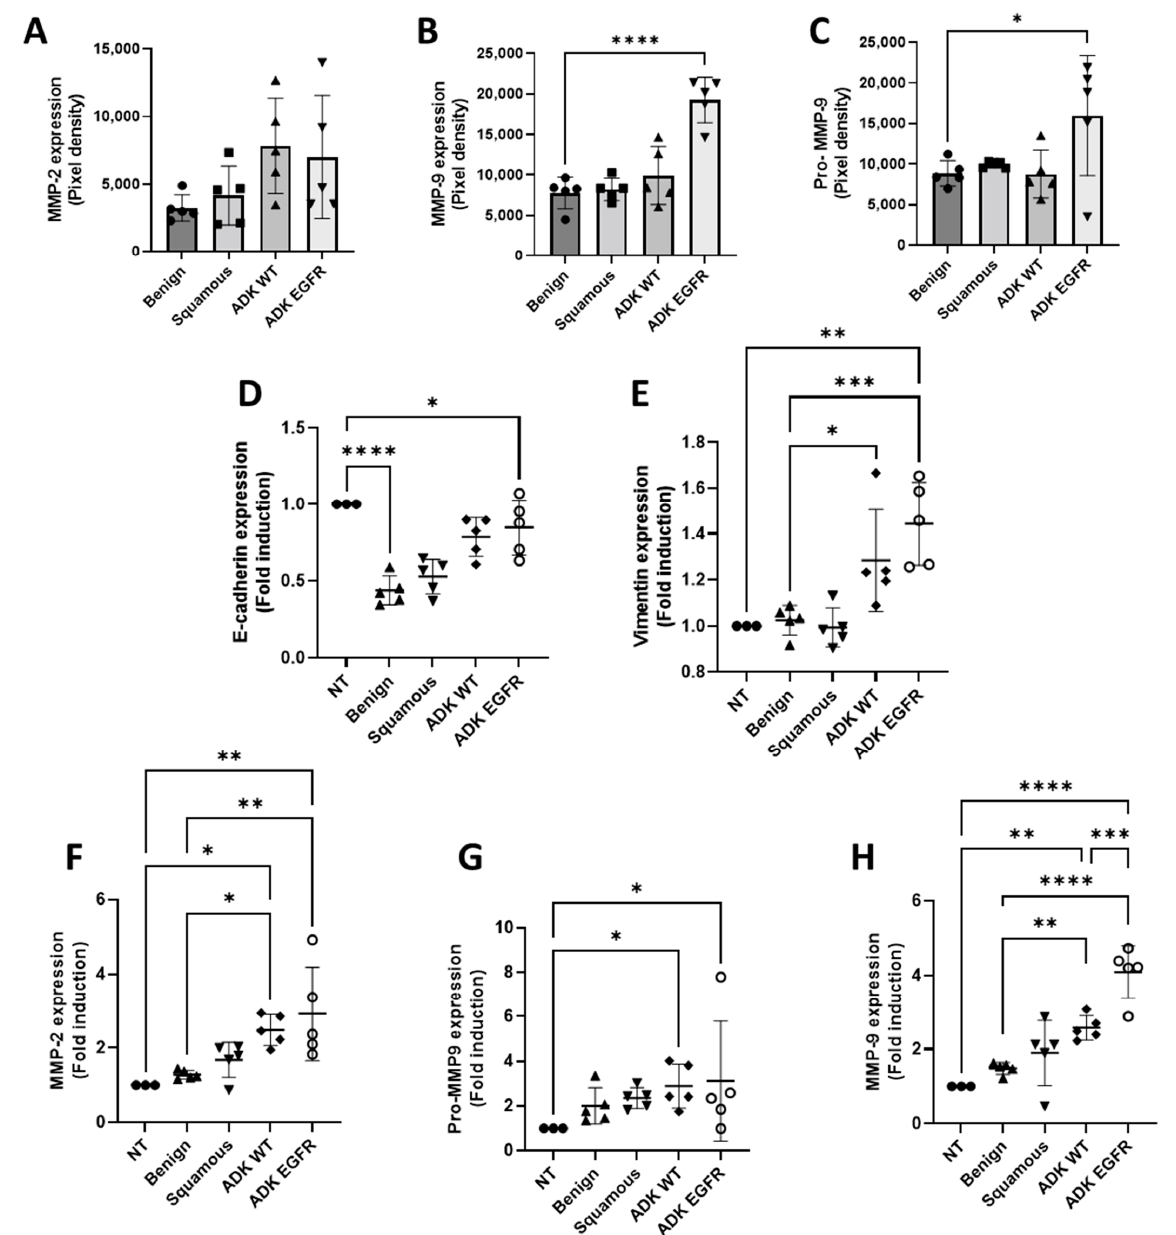
Figure 3. Exosomes from serum of EGFR -mutated patients promote extracellular matrix degradation and EMT-like process ( A – C ) Quantification analysis of expression of MMPs obtained by zymography in exosomes isolated from serum (mean ± SEM, n = 5). ( D , E ) Quantification analysis of vimentin and E-cadherin expression obtain by Western blotting of protein extracts of A549 cells treated with exosomes isolated from serum. GAPDH is used as a loading control (mean ± SEM, n = 5). ( F – H ) Quantification analysis of expression of MMPs obtained by zymography of supernatant of A549 cells treated with exosomes isolated from serum (mean ± SEM, n = 5). Significance was set at * p < 0.05, ** p < 0.01, *** p < 0.001 and **** p < 0.0001. To further investigate the functionality of exosomes isolated from serum from patients with EGFR mutation, we developed a cellular model mimicking their effects in vitro using exosomes from an EGFR -mutated cell line: HCC827 harboring EGFR Del E746-A750 in exon 19, the most common activating mutation [22]. After exposure to exosomes derived from HCC827 cell line (exo-HCC827), cells were stained for vimentin and E-cadherin using im- munofluorescence. A change in cellular architecture was observed, with A549 cells